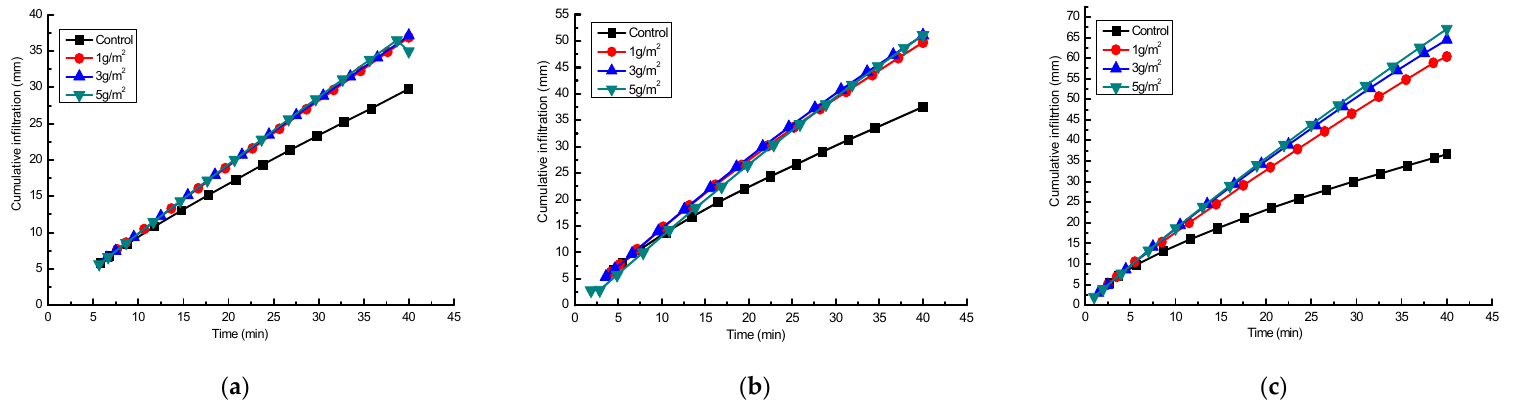
Figure 4. Cumulative infiltration of spraying Jag C162 under three rainfall intensities. ( a ) 1.0 mm/min; ( b ) 1.5 mm/min; ( c ) 2.0 mm/min.